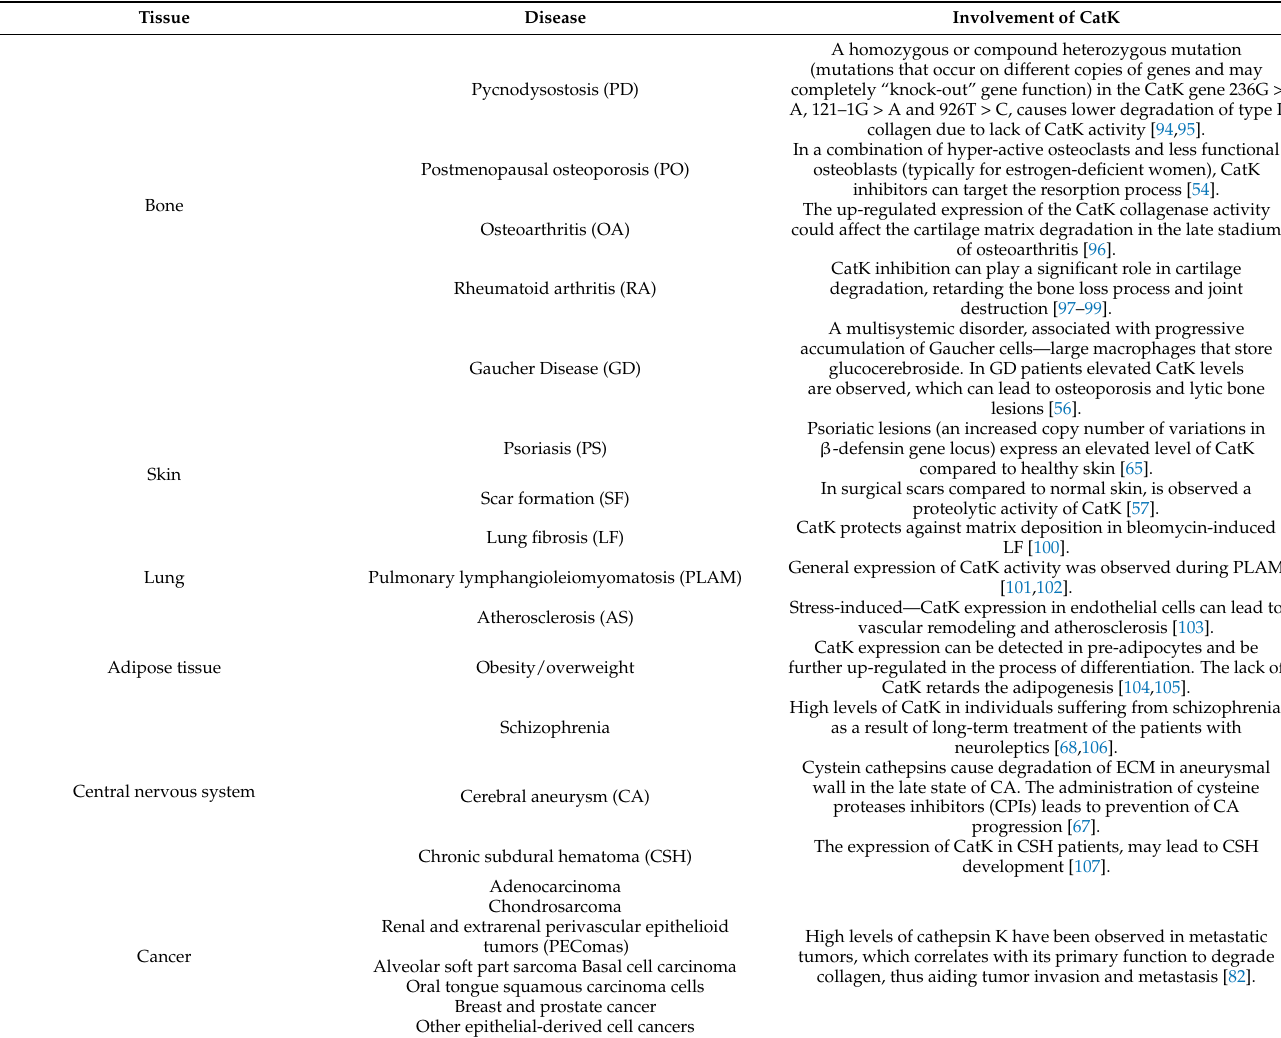
Table 1. Involvement of CatK in different diseases classified by